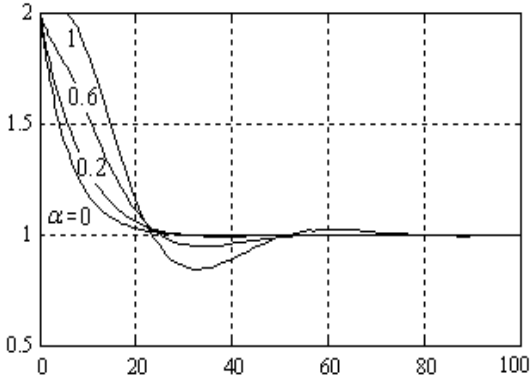
Figure 4. Control responses c ( t ) to a unit step reference for process (31), G M ( s ) = G P ( s ) , K = 2, and α = 0; 0.2; 0.6; 1.